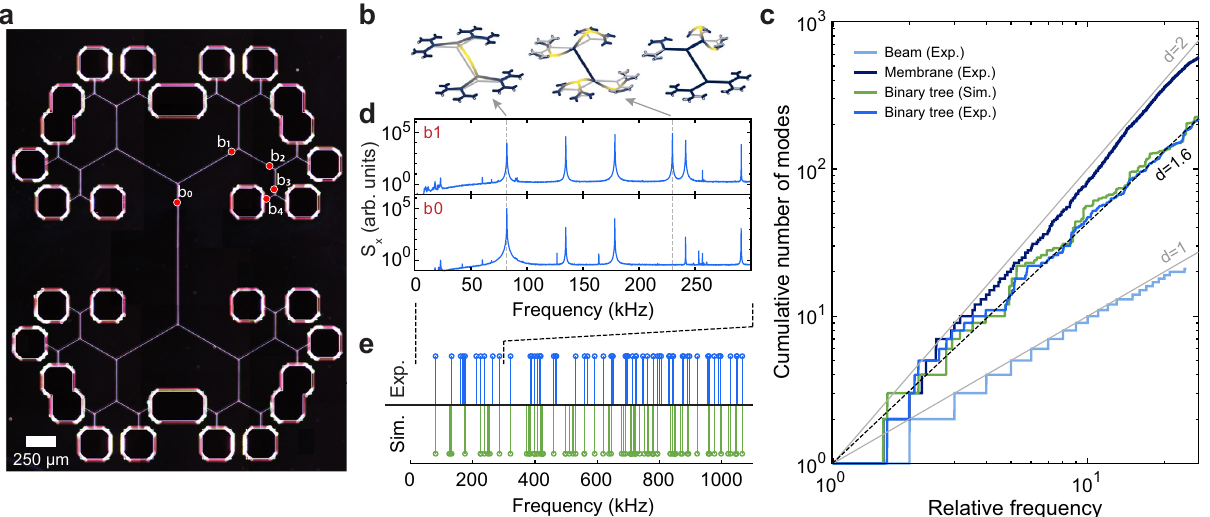
Fig. 3 Mode density of self-similar mechanical resonators. a Dark fi eld optical image of the measured device. b Simulated mode shapes of the mechanical modes indicated in the thermomechanical spectra of d . c Cumulative mode density measured for a uniform beam, a binary tree beam and a square membrane. For the binary tree beam, we also show the cumulative mode density expected from simulation. The gray lines indicate linear and quadratic scaling. d Thermomechanical noise spectra acquired in low vacuum by optical readout at the points indicated in a . e Comparison of simulated and measured resonant frequencies. The indicated interval corresponds to the frequency range in d